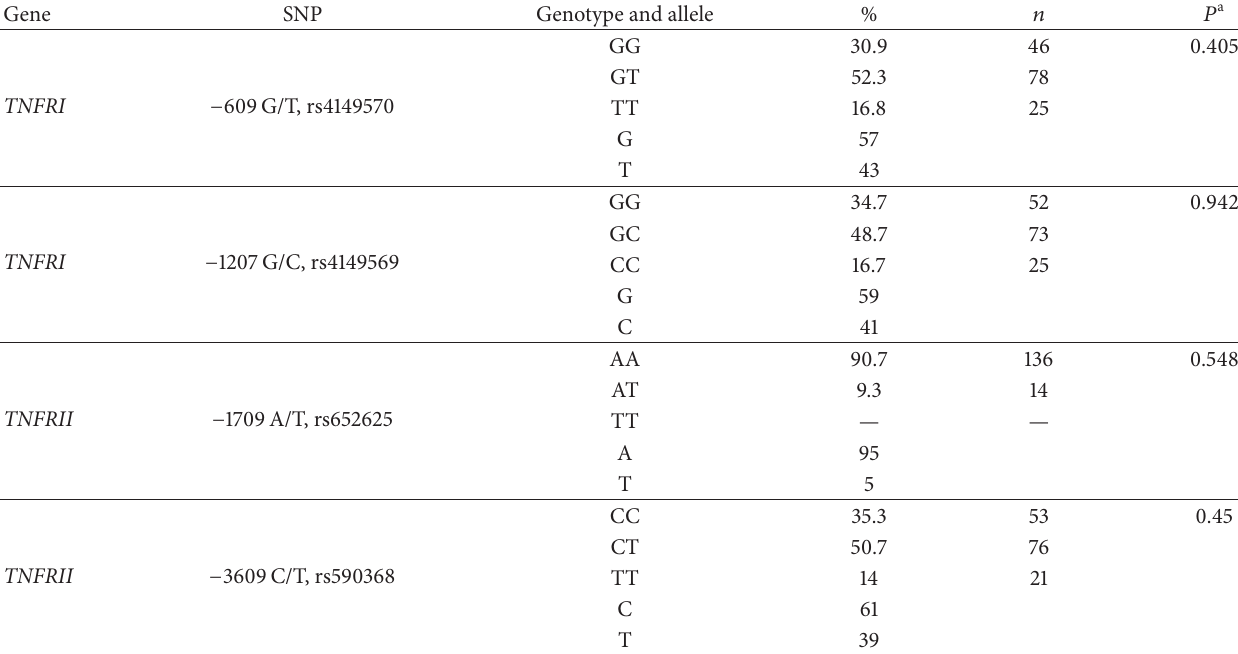
Table 3: Genotype and allele distributions of TNFRI and TNFRII gene polymorphisms from healthy individuals from Novosibirsk (South- Western Siberia, Russia, 𝑛 = 150